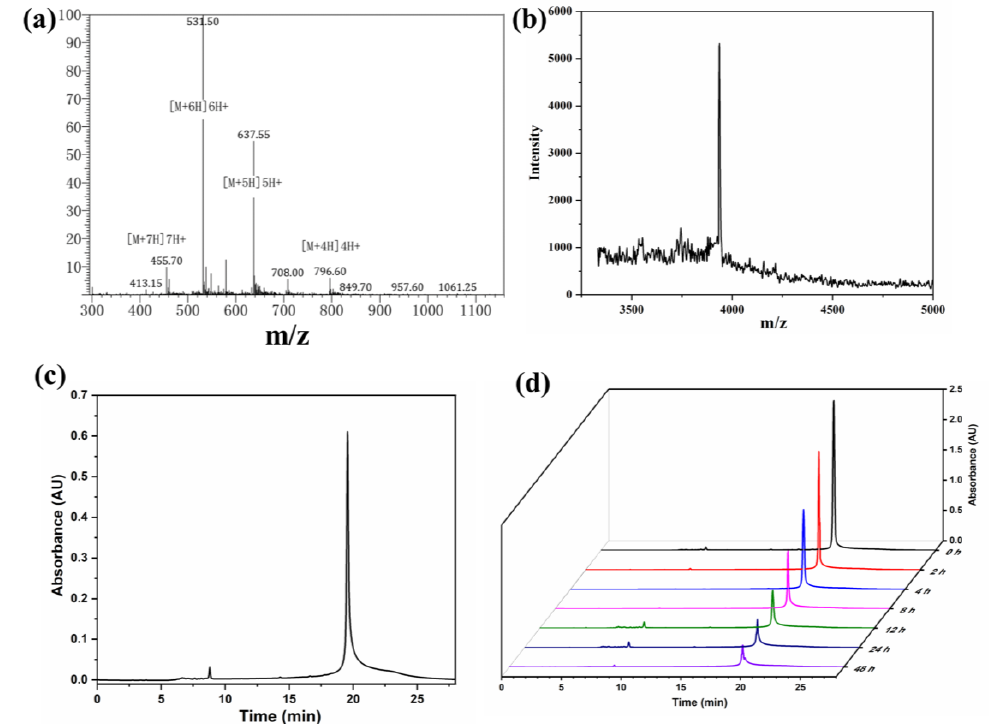
Figure 2. ( a ) Representative electrospray ionization (ESI) mass spectra of HP peptides. ( b ) MALDI- TOF mass spectrometry of the PDC. ( c ) Analysis and purification of the PDC by HPLC. ( d ) The stability of the PDC evaluated by